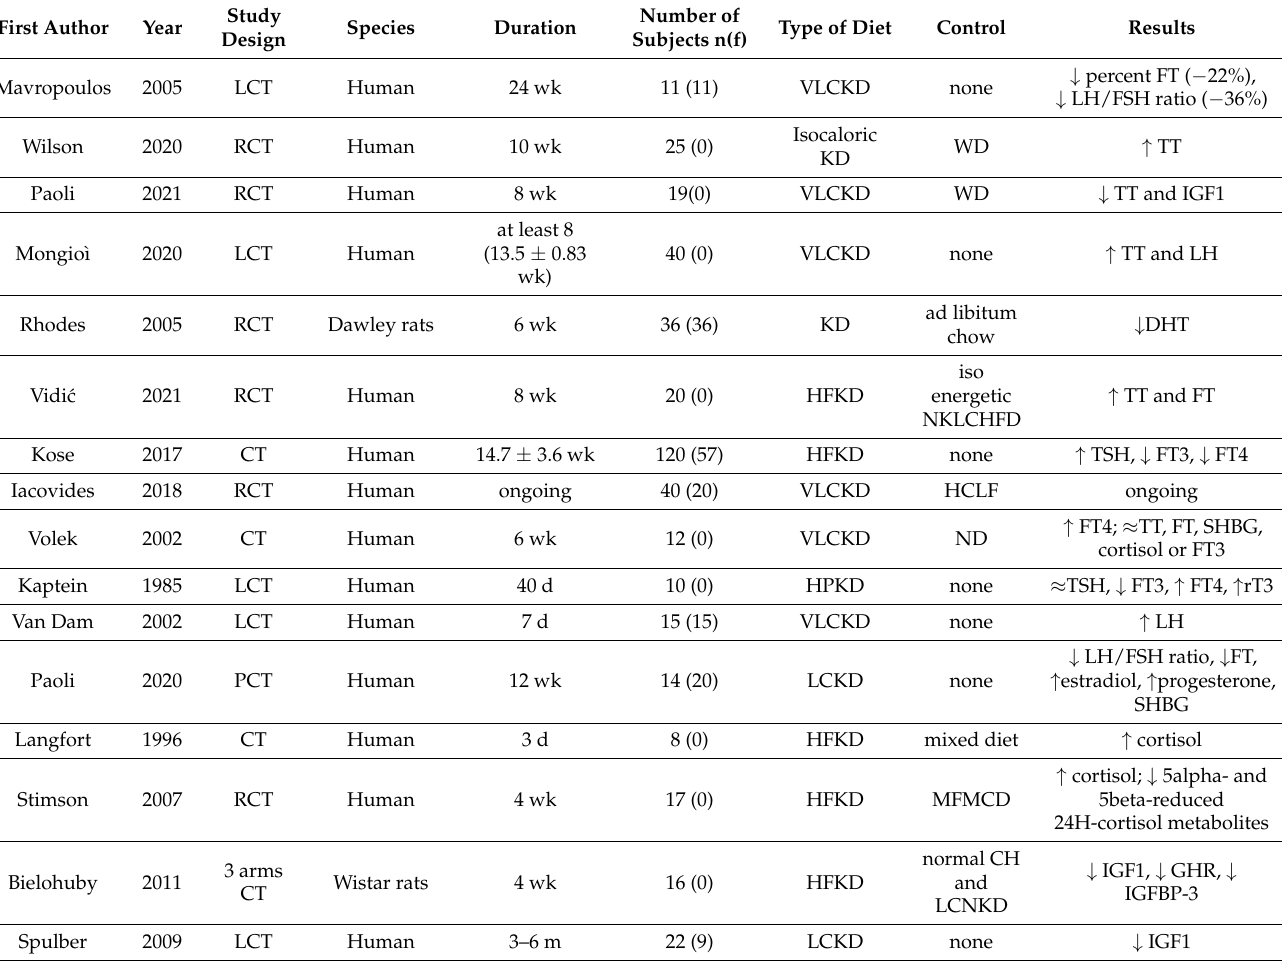
Table 3. Selected studies regarding the effect of a ketogenic diet on hormone